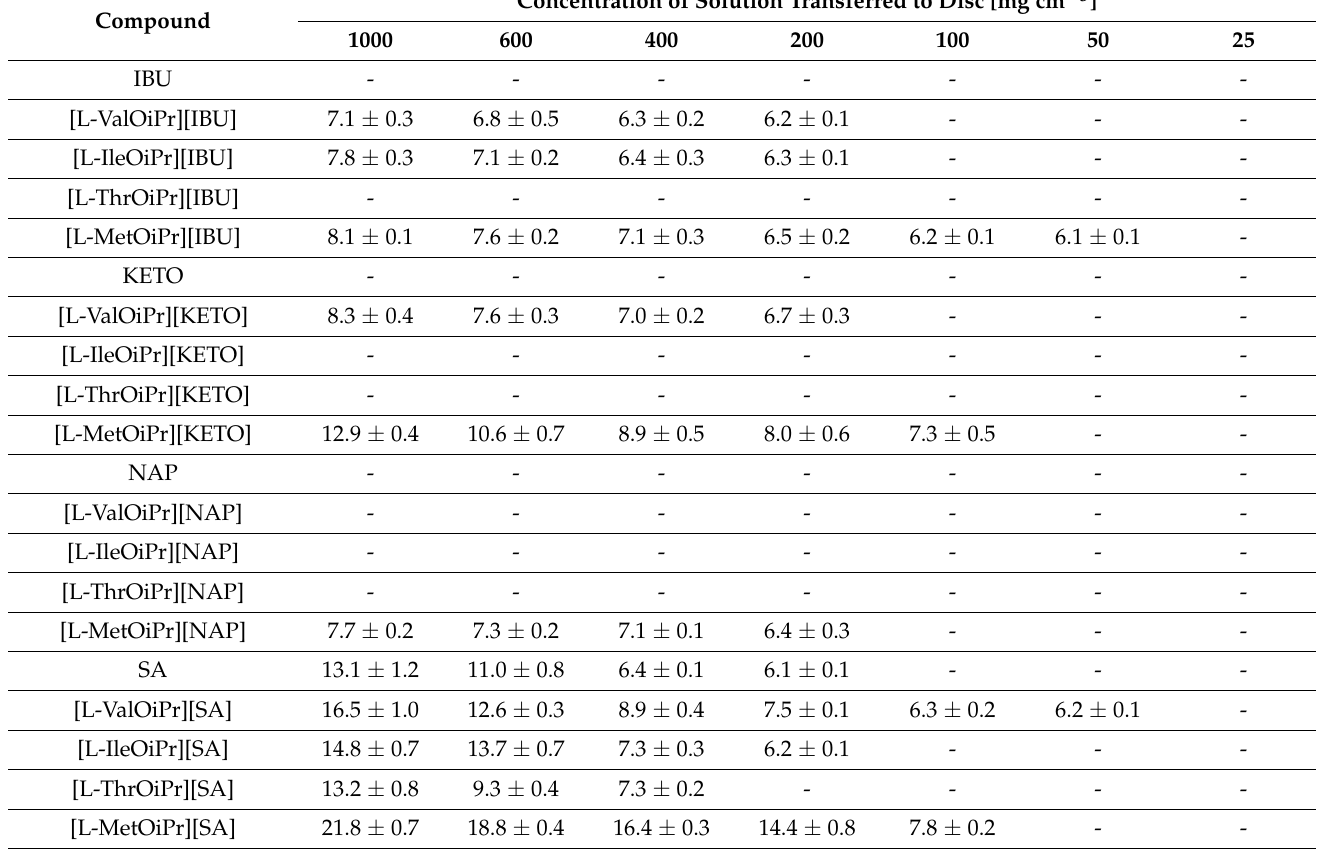
Table 6. Antimicrobial activity against Escherichia coli of acids from NSAID groups and their L-amino acid isopropyl ester salts, Inhibition diameter